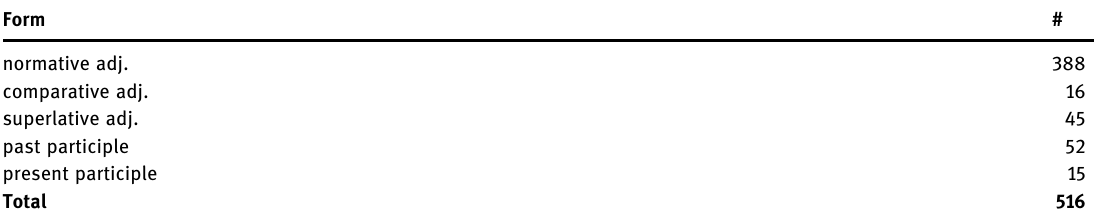
Table 5: Form of the modi fi er Form